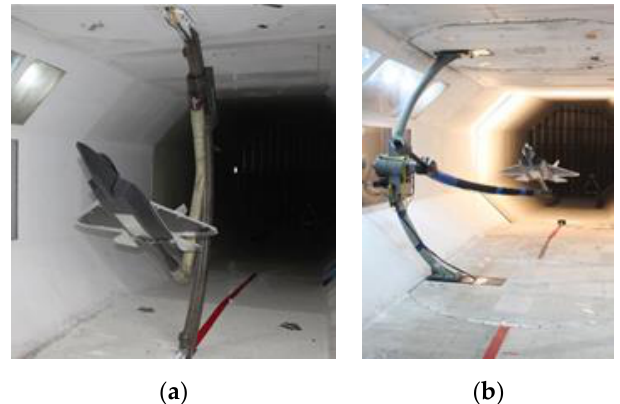
Figure 2. Traditional wind tunnel test. ( a ) Static force test; ( b ) Dynamic derivatives and large oscillation test.